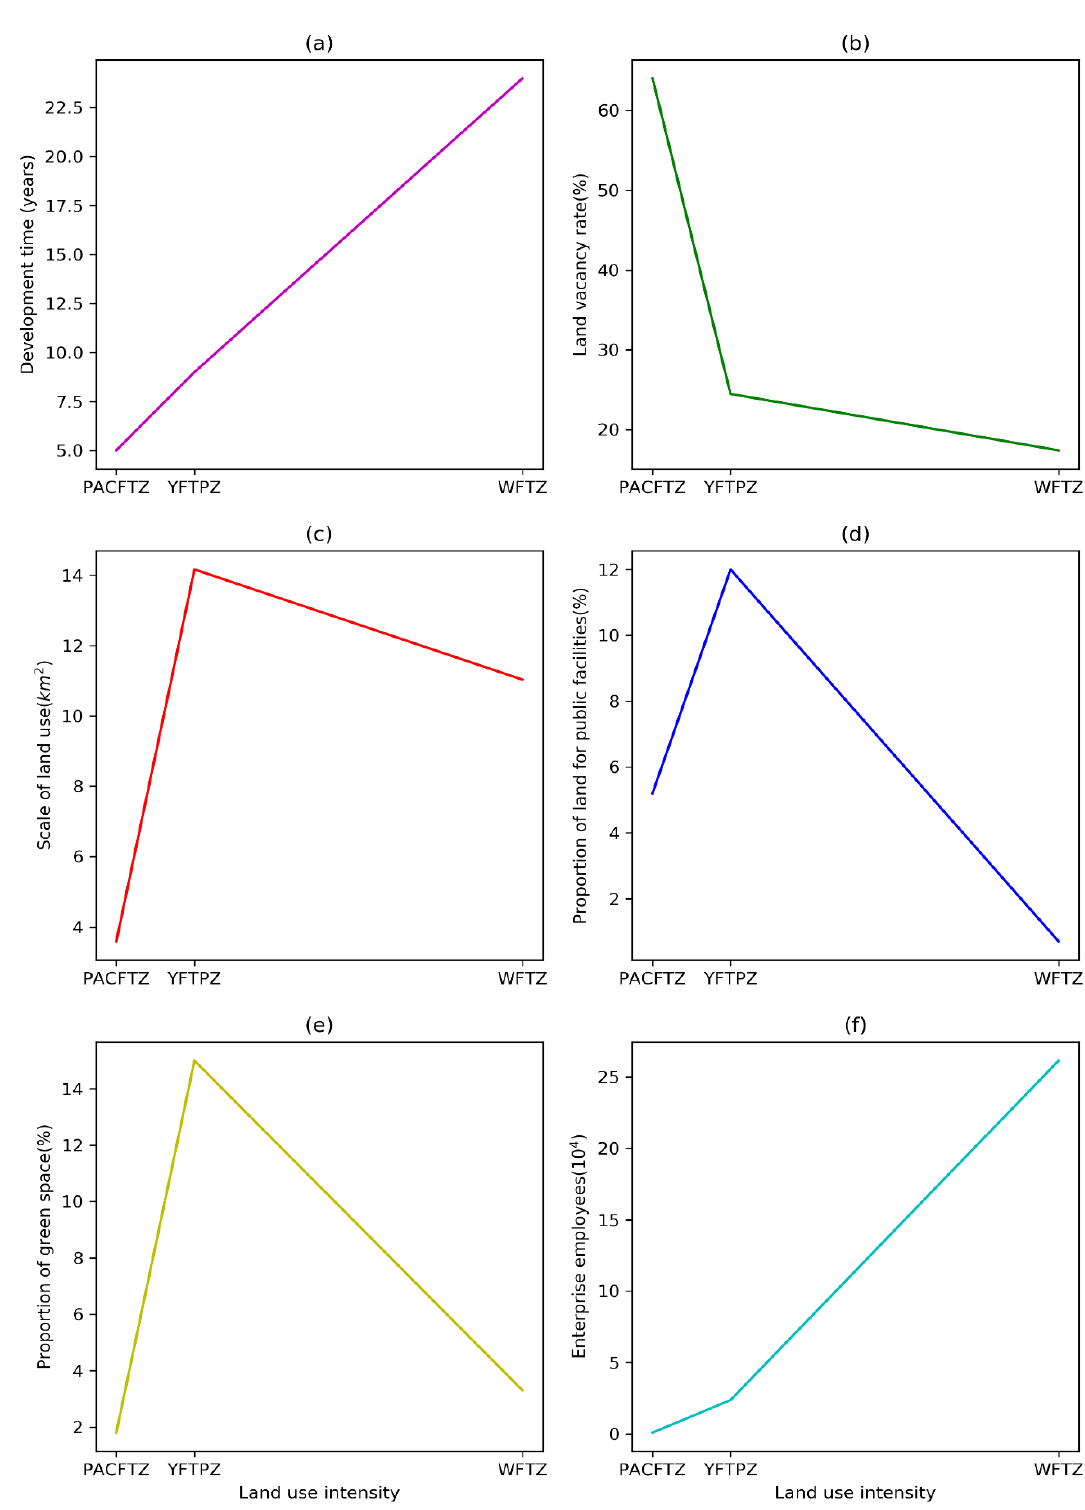
Figure 3. Relationship between land use intensity and impacting factors in the SPFTZ. Notes ： ( a ) The relationship between land use intensity and development times; ( b ) The relationship between land use intensity and land vacancy rate; ( c ) The relationship between land use intensity and scale of land use; ( d ) The relationship between land use intensity and proportion of land for public facilities; ( e ) The relationship between land use intensity and proportion of land for green space; ( f ) The relationship between land use intensity and enterprise employees.